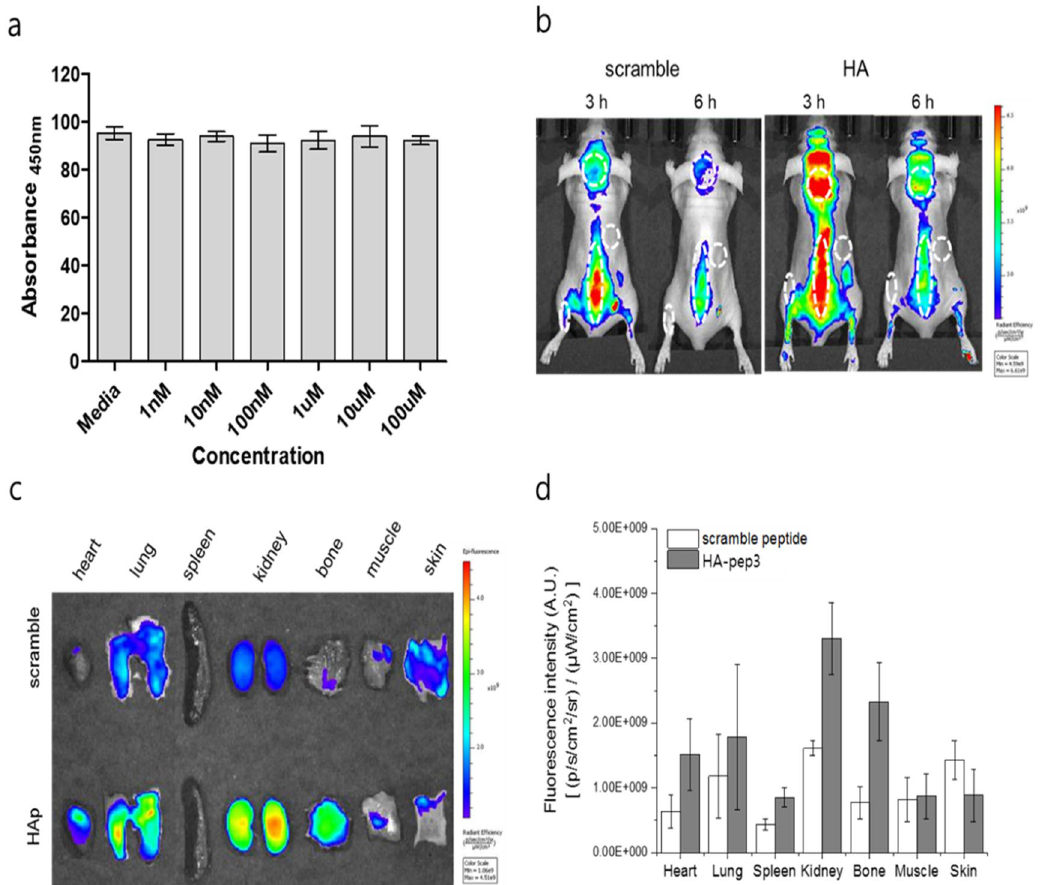
and Cy5.5-HA pep3. Skin, skull, spine, and joint are marked as dashed lines. ( c ) Ex vivo fluorescence imaging of bone and major tissues using the HA-pep3 and scramble peptide. ( d ) Fluorescence signal intensity graph of HA-pep3 and scramble peptide in bone and major